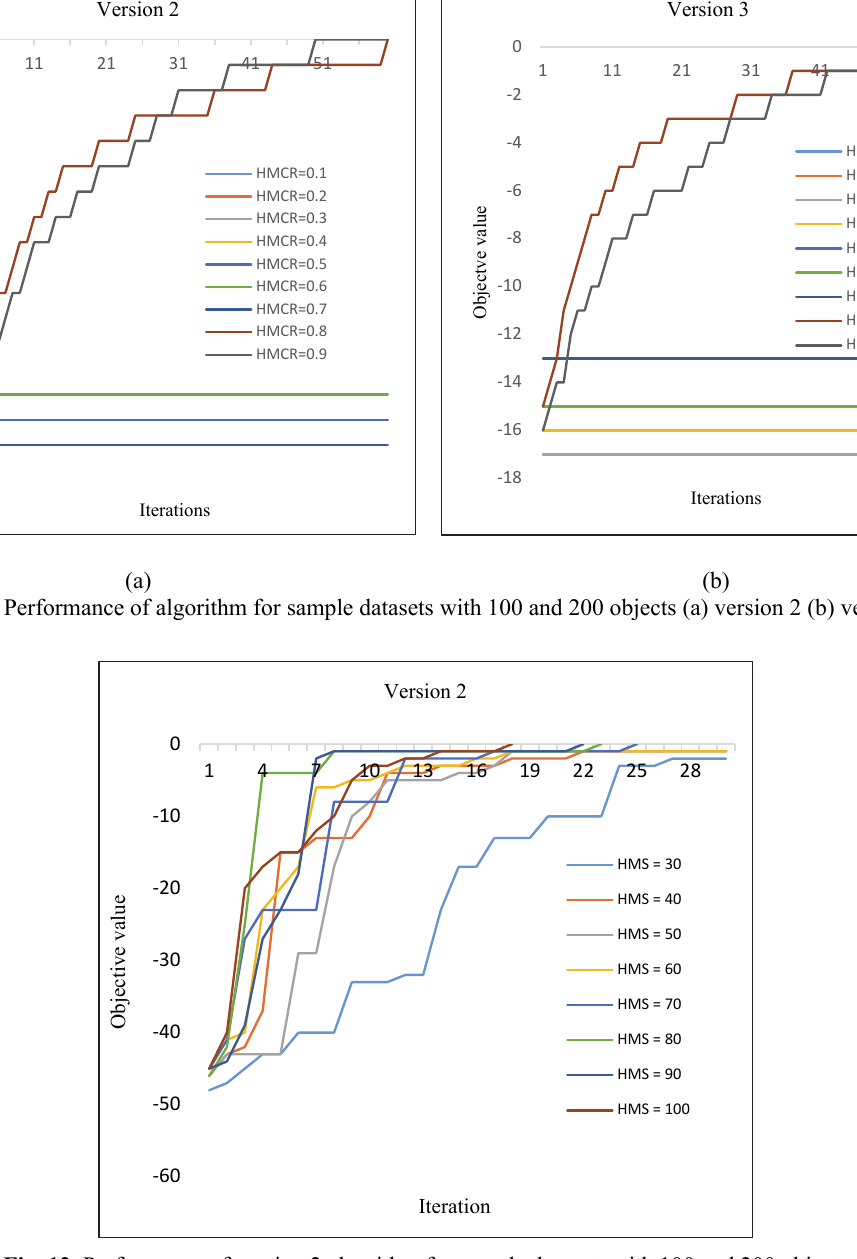
Fig. 12. Performance of version 2 algorithm for sample datasets with 100 and 200